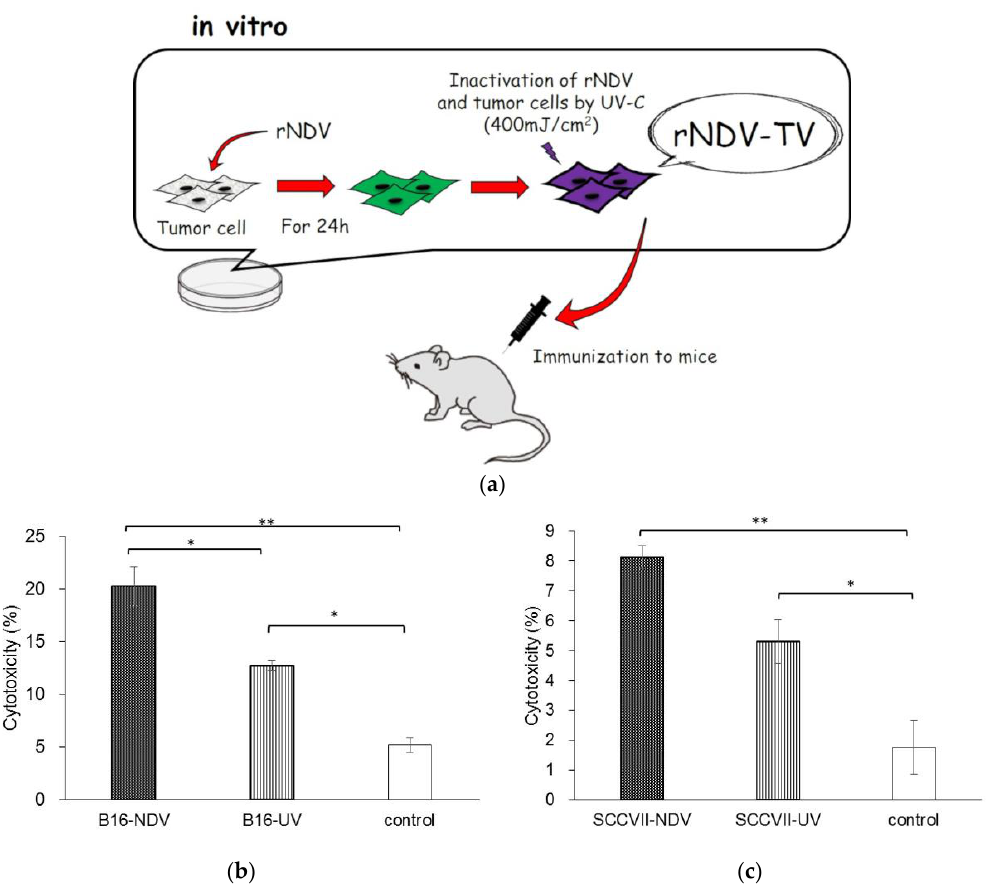
Figure 1. Newcastle disease virus (NDV)-infected tumor vaccines (NDV-TV) model and induction of antitumor response by rNDV-TV. ( a ) The schematic of NDV-TV model was shown. The tumor cells were infected with rNDV in vitro, irradiated by ultraviolet for inactivation of rNDV and tumor cells. Then rNDV-TV was administered to mice as immunogen. rNDV-TV ( n = 3), UV-TV (ultraviolet irradiated tumor vaccine) ( n = 3), or each medium ( n = 2) were administered to mice and